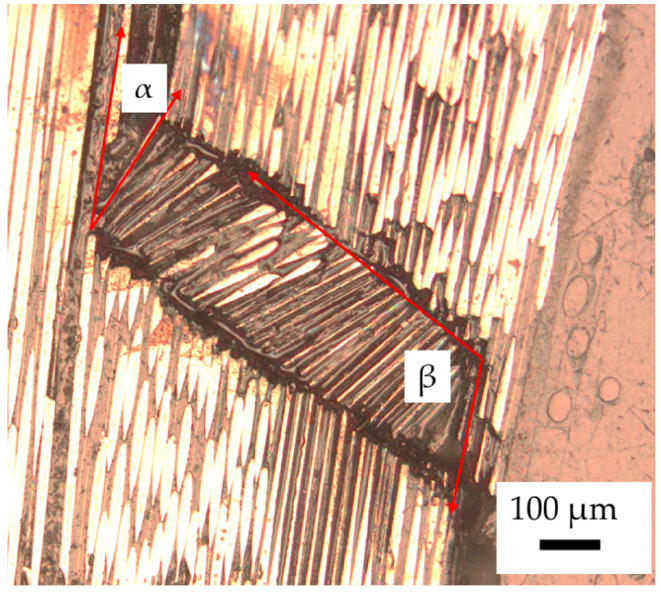
Figure 4. Kink band formation in CFRP, where α is the rotation angle of fibre and β is the kink band angle. band